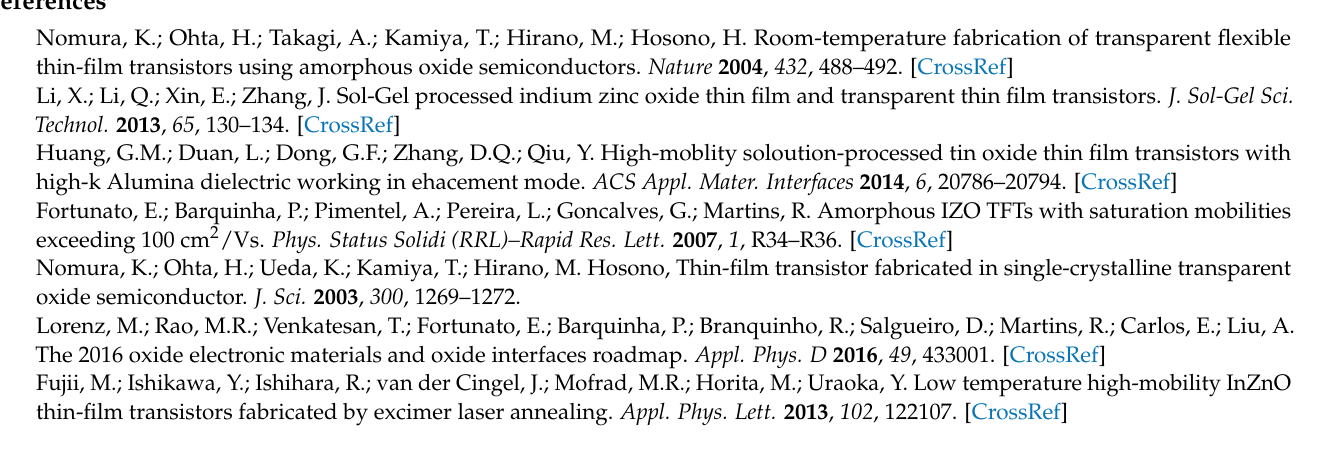
Figure 9. ( a ) PBS Transfer curve of the In 2 O 3 /HfO 2 TFTs; ( b ) NBS Transfer curve of the In 2 O 3 /HfO 2 TFTs.